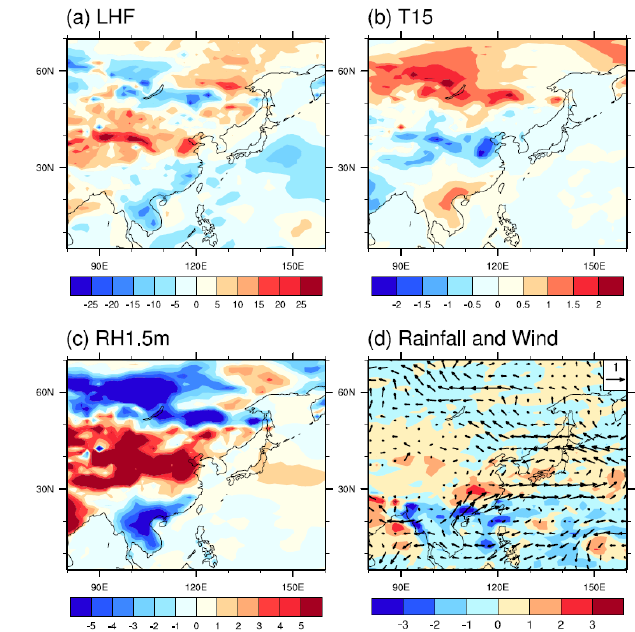
Figure 12. Contribution by the land cover changes alone to the future–present differences in JJA (represented by (AEnodts − AEnod) – (Ats − A)) in (a) latent heat flux (Wm − 2 ) , (b) surface air temperature (K), (c) 1.5m relative humidity (%) and (d) rainfall (shading, mmday − 1 ) and 850hPa wind (vectors, ms − 1 )